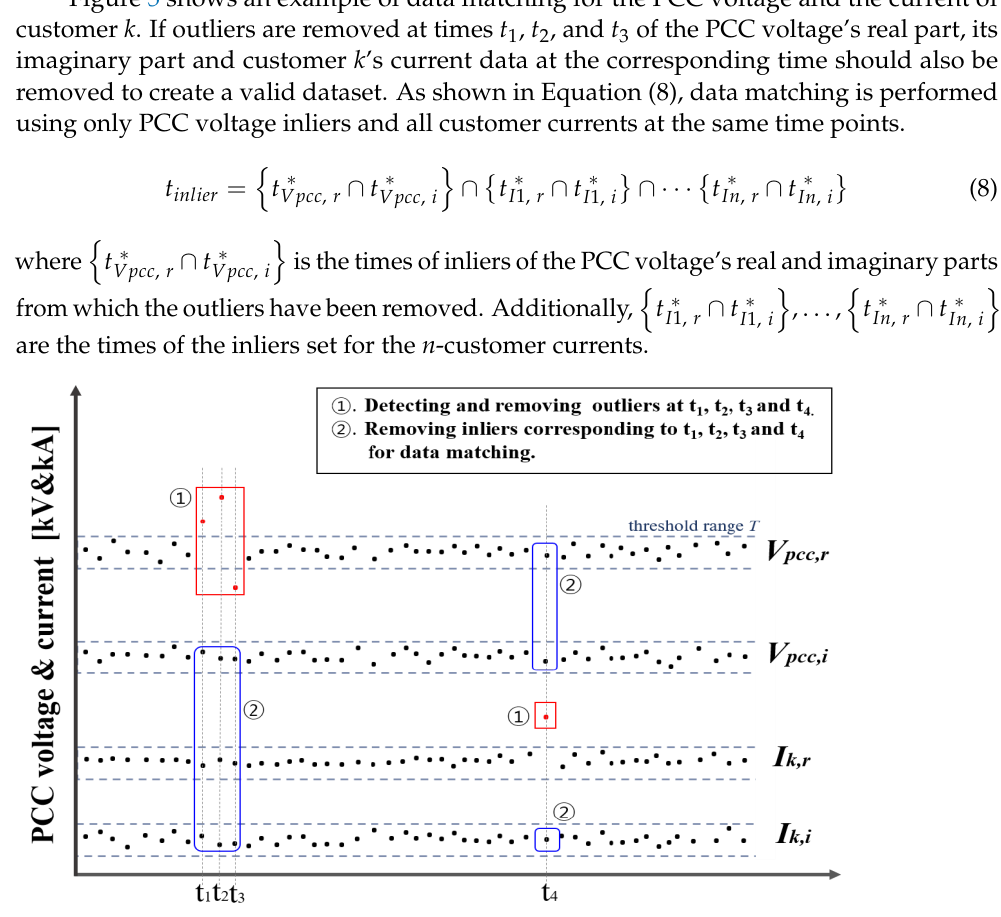
Figure 5. Data matching for PCC voltage and currents.